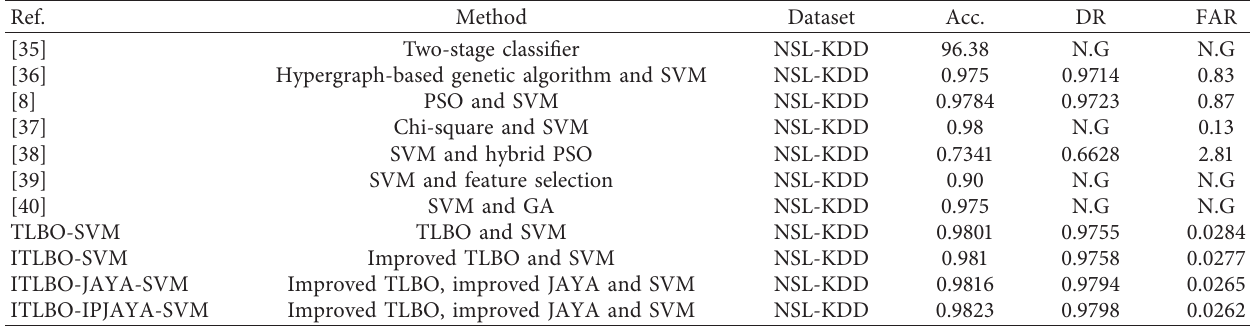
Table 14: Comparison with the existing work for the NSL-KDD dataset. Ref.